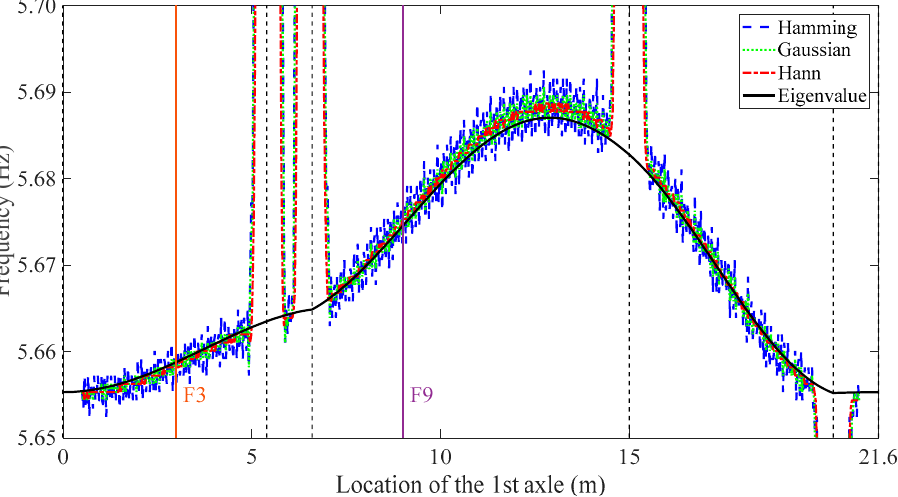
Figure 7. Comparison of the eigenvalue curve and the STFT of the undamped bridge response due to the truck travelling at 1 m/s on a smooth profile using three different window functions.